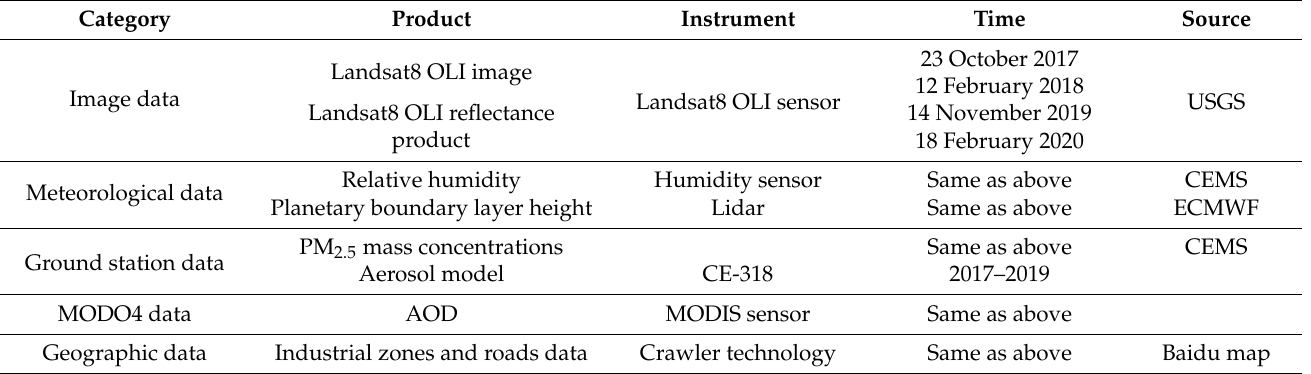
Table 1. Details of the data used in this study.